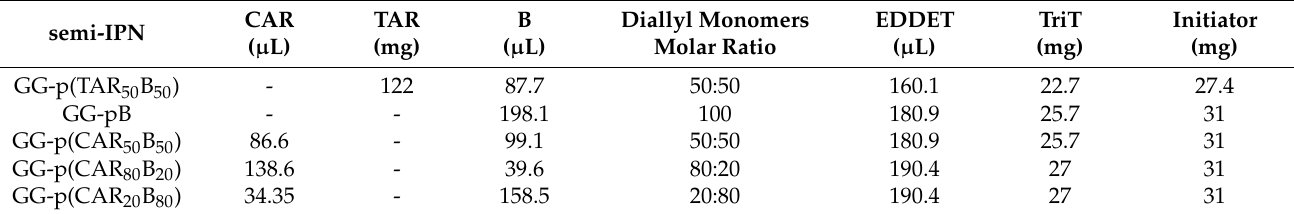
Table 4. Preparation of guar-gum-based semi-IPNs.